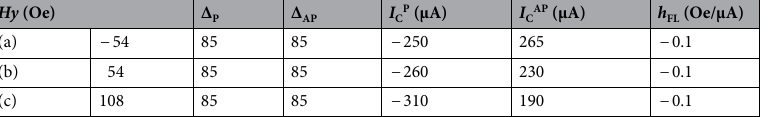
Table 1. Parameters used to fit the experimental data on DC current induced switching. The other fixed parameters are: H K : 300 Oe, H s : 54 Oe.